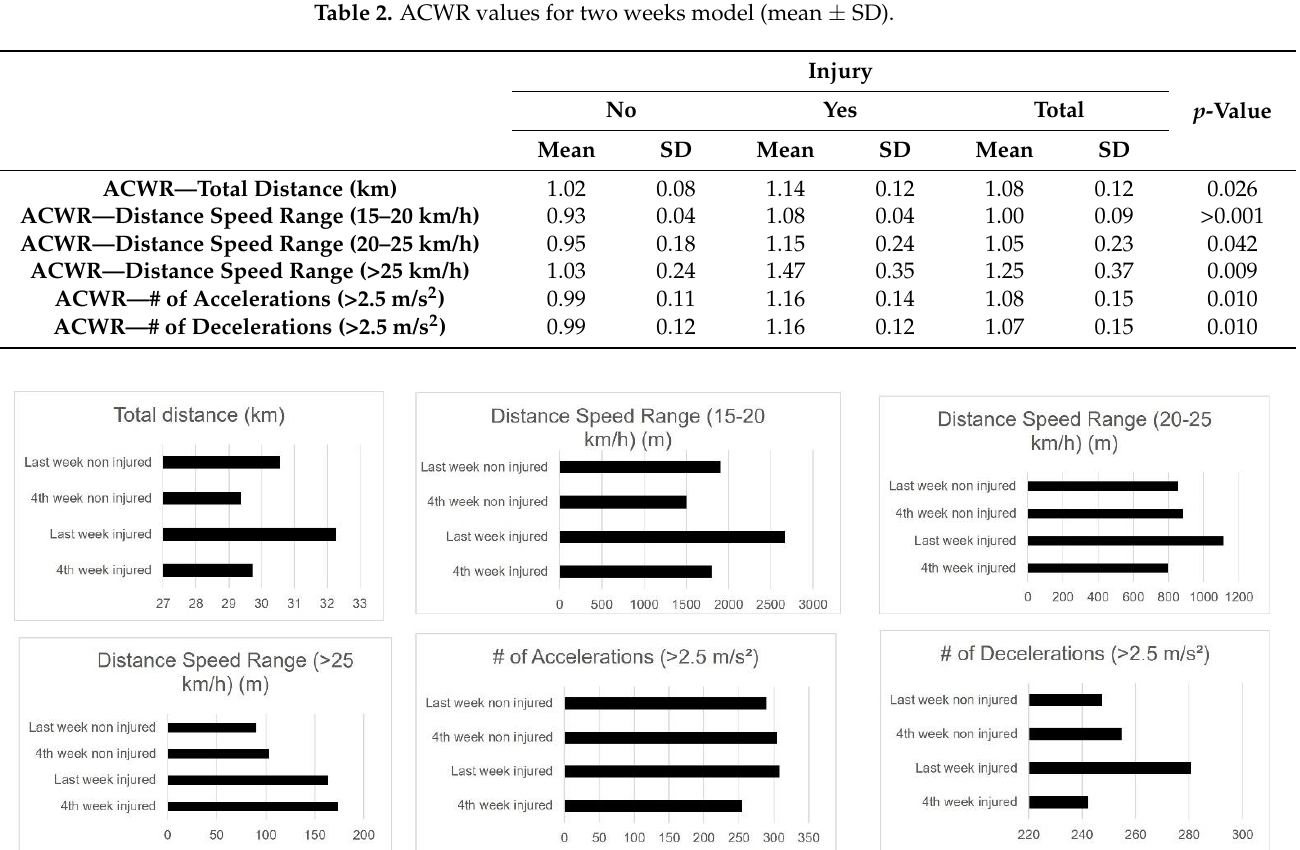
Figure 2. Values of injured and non-injured soccer players for two-week model. # denotes number.